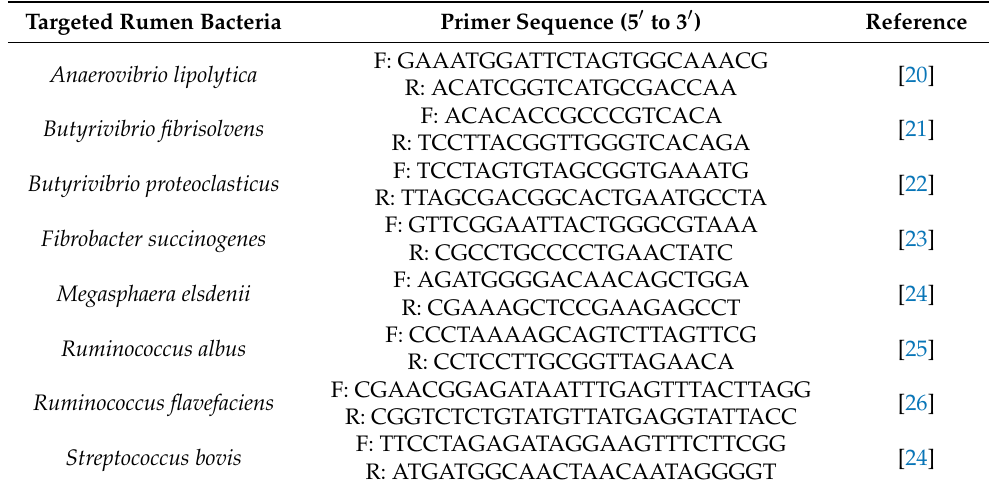
Table 3. Forward (F) and reverse (R) primers used in the RT-PCR analysis of rumen bacteria. Targeted Rumen